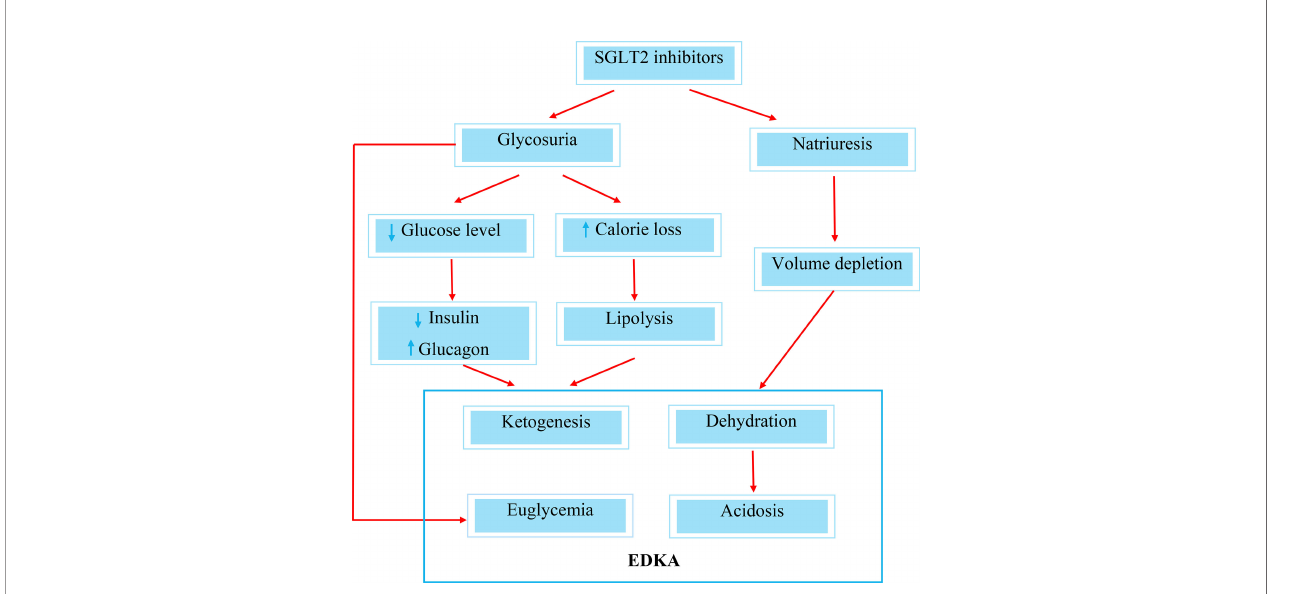
FIGURE 2 | Mechanisms of SGLT2 inhibitor-induced Euglycemic Diabetic Ketoacidosis